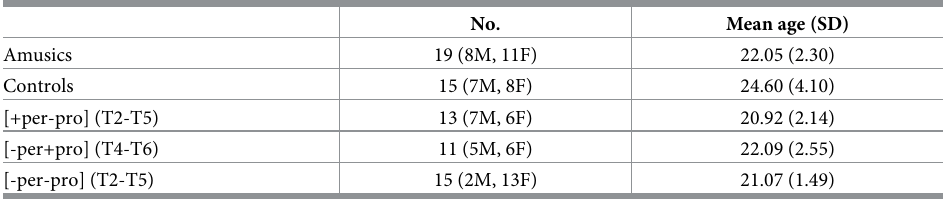
Table 1. Demographic information of the five groups of